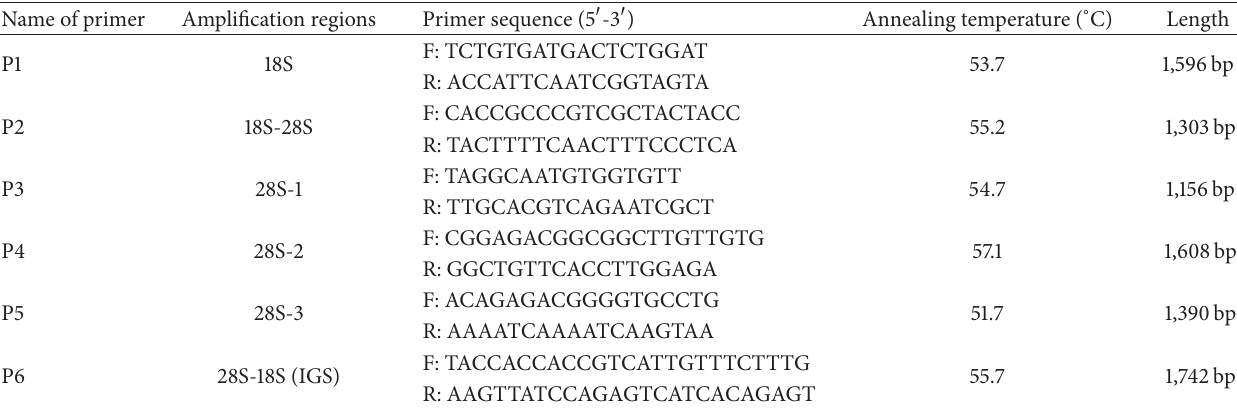
Table 1: Primers used to amplify the complete rDNA sequence of Paramphistomum cervi . The upper and lower sequences are forward (F) and reverse (R) for each primer, respectively.